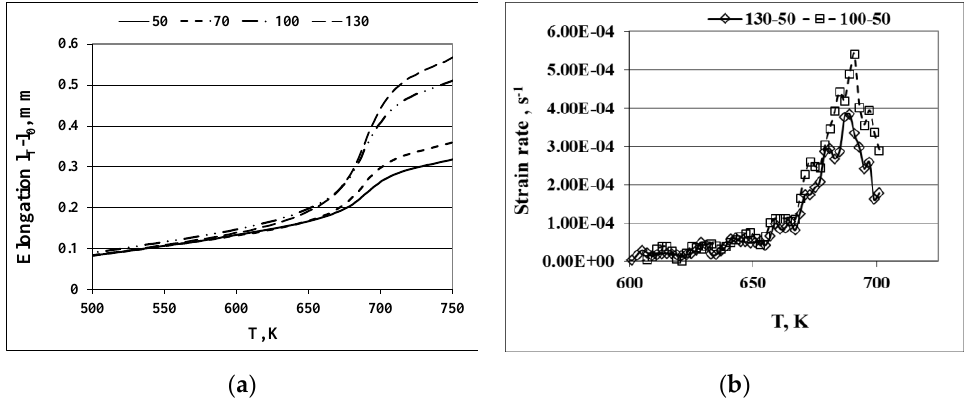
Figure 2. Experimental elongation [ l ( T ) − l 0 ] vs. the temperature curve of the Pd 40 Ni 40 Si 20 glassy alloy at a heating rate of 20 K/min with 4 different loads: 50 g (11.9 MPa), 70 g (16.7 MPa), 100 g (23.8 MPa), and 130 g (31.0 MPa) ( a ) and the temperature dependences of the strain rates ( b ).